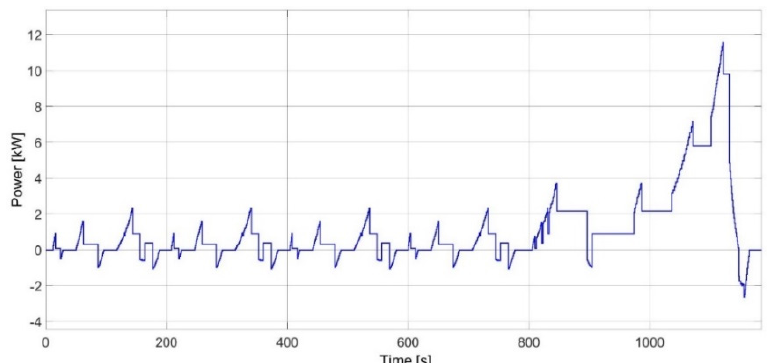
Figure 14. Demand load considered for the examinations.